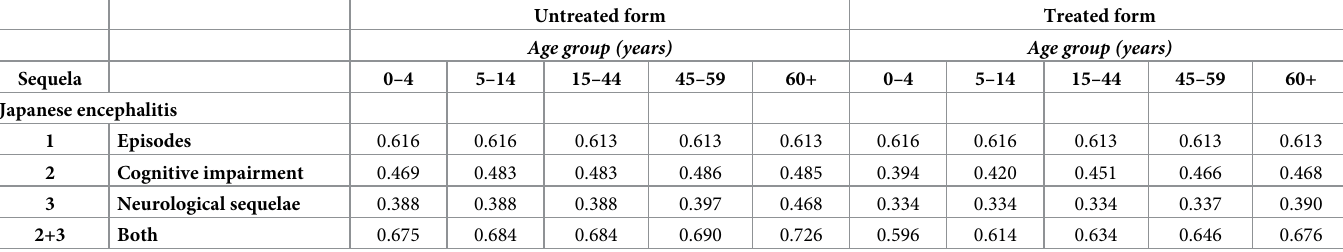
Table 1. Age-specific disability weights for untreated and treated forms of sequelae included in the Global Burden of Disease Study for Japanese encephalitis